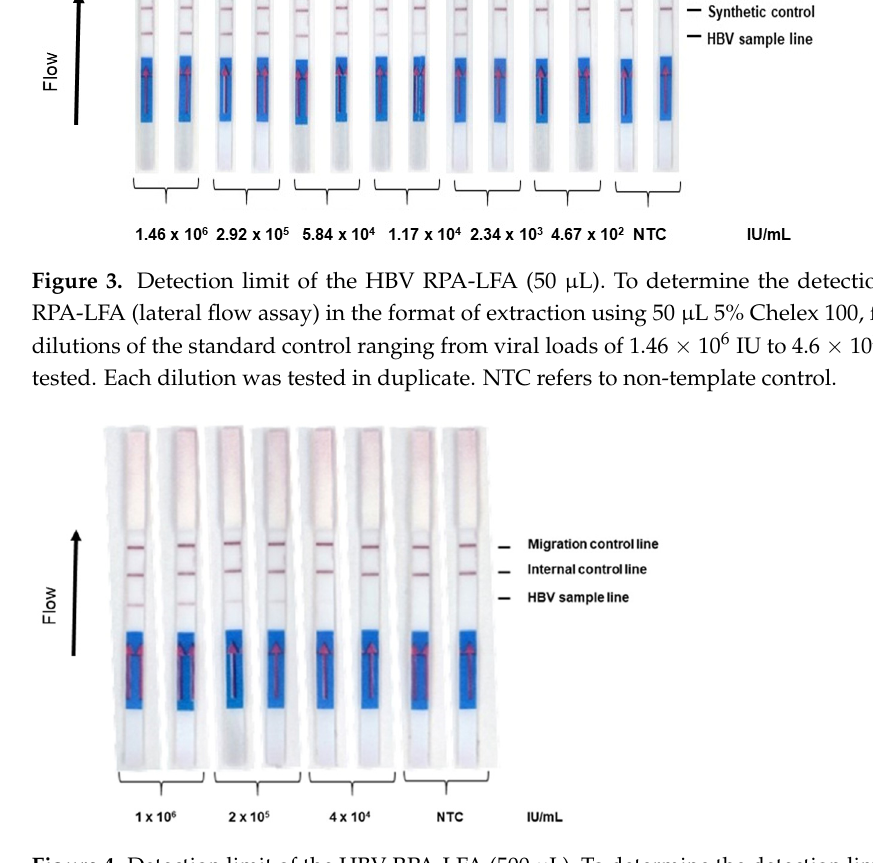
Figure 3. Detection limit of the HBV RPA-LFA (50 µL). To determine the detection limit of the RPA- LFA (lateral flow assay) in the format of extraction using 50 µL 5% Chelex 100, five-fold serial dilu- tions of the standard control ranging from viral loads of 1.46 × 10 6 IU to 4.6 × 10 2 IU/mL were tested. Each dilution was tested in duplicate. NTC refers to non-template control.